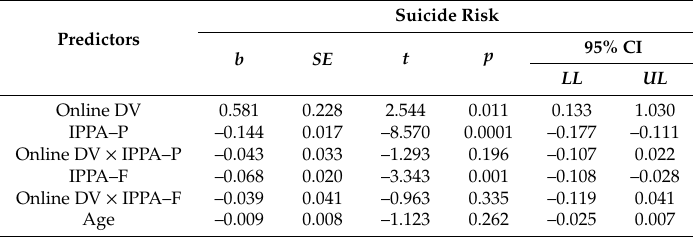
Table 5. Moderation Analyses: Conditional e ff ects of Online on Suicide Risk at Di ff erent Values of the IPPA–P, IPPA–F.